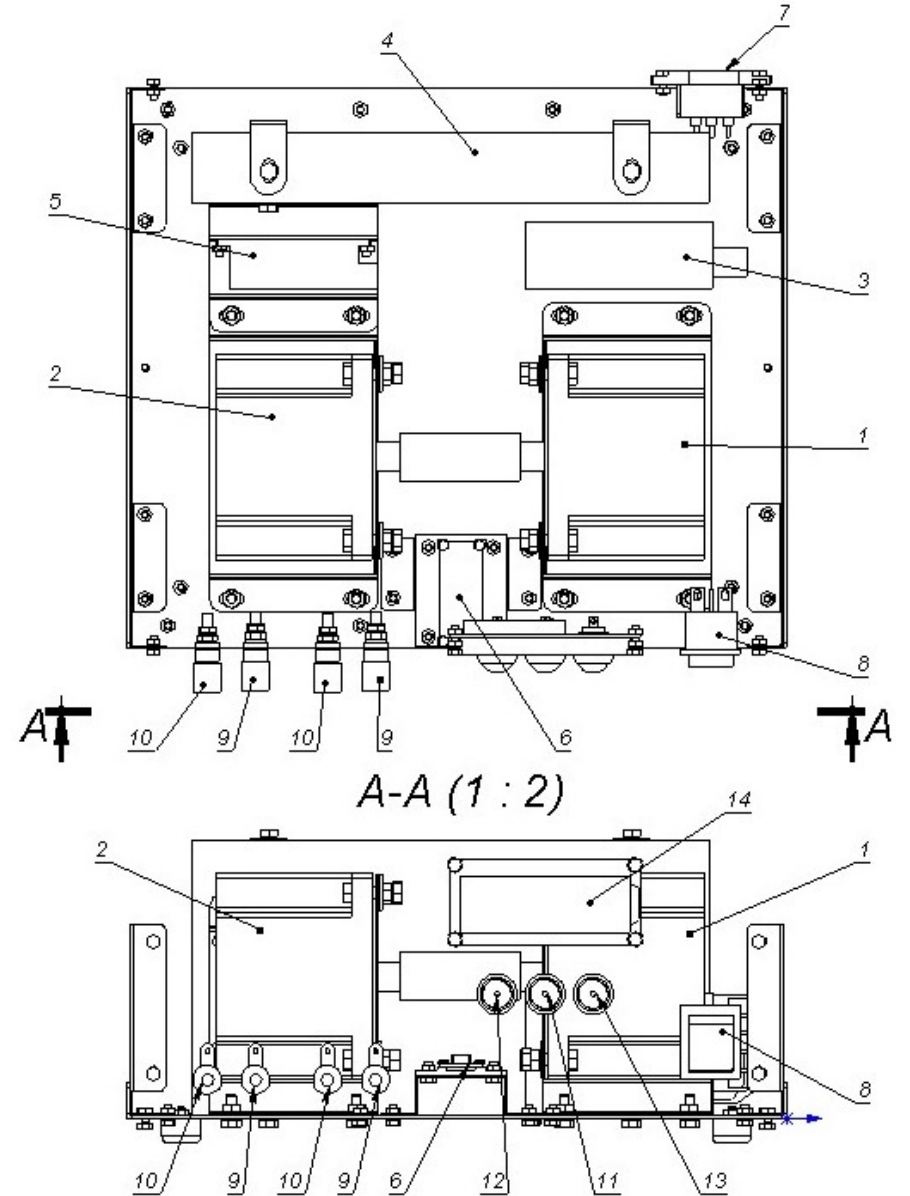
Figure 2. Schematic diagram of the WEC